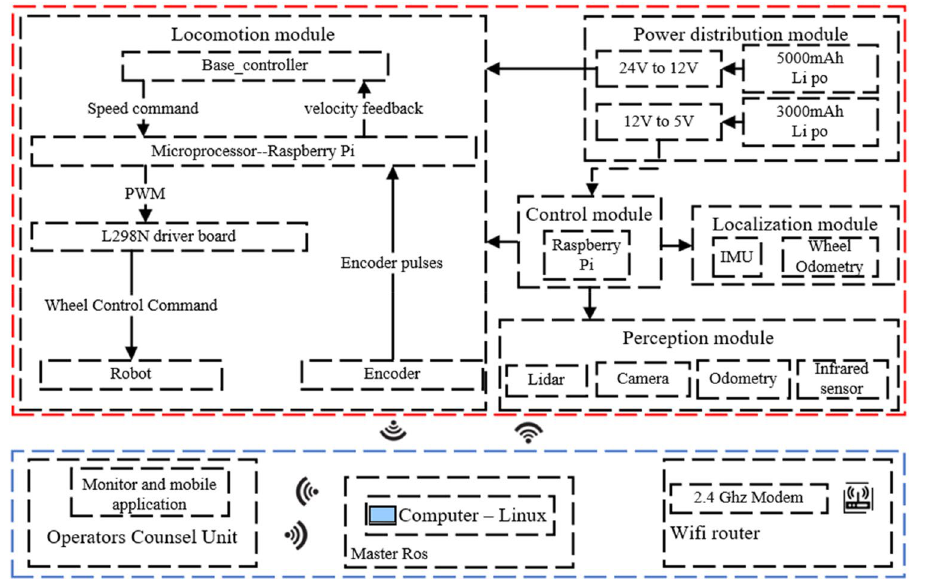
Figure 8. Control system of the